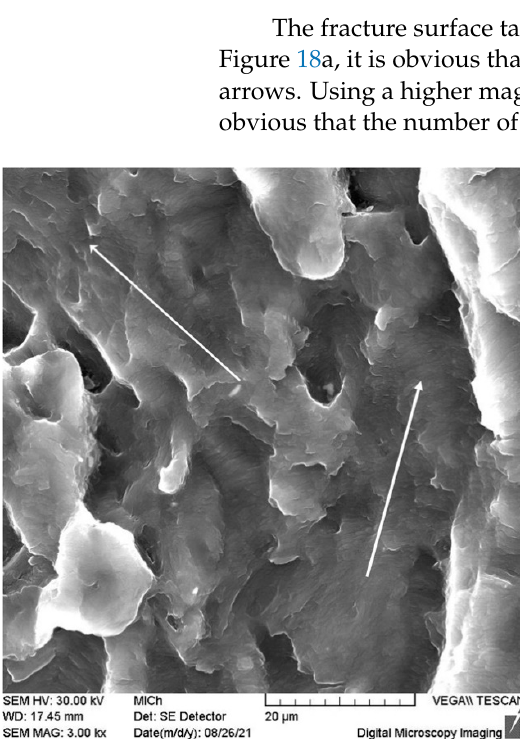
( b ) Figure 19. Scanning electron micrograph taken from the transition region ( a ), dimple on the frac- ture surface with fine striations inside ( b ).